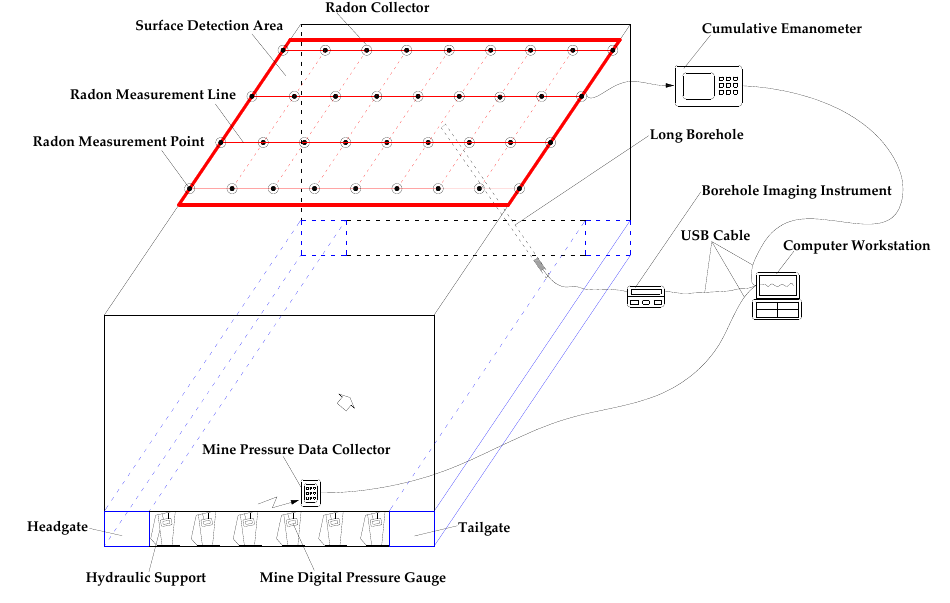
Figure 1. Schematic of the detection site.